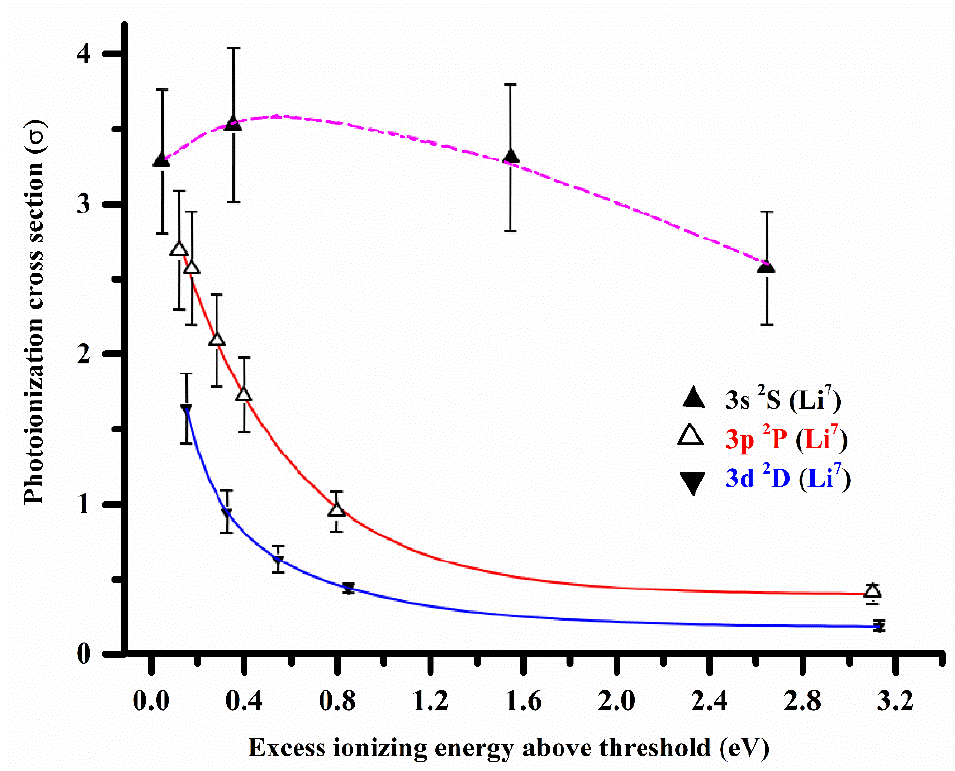
Figure 4. A comparison of the energy-dependent behavior of the measured values of the photoion- ization cross-section from the 3s 2 S, 3p 2 P, and 3d 2 D.